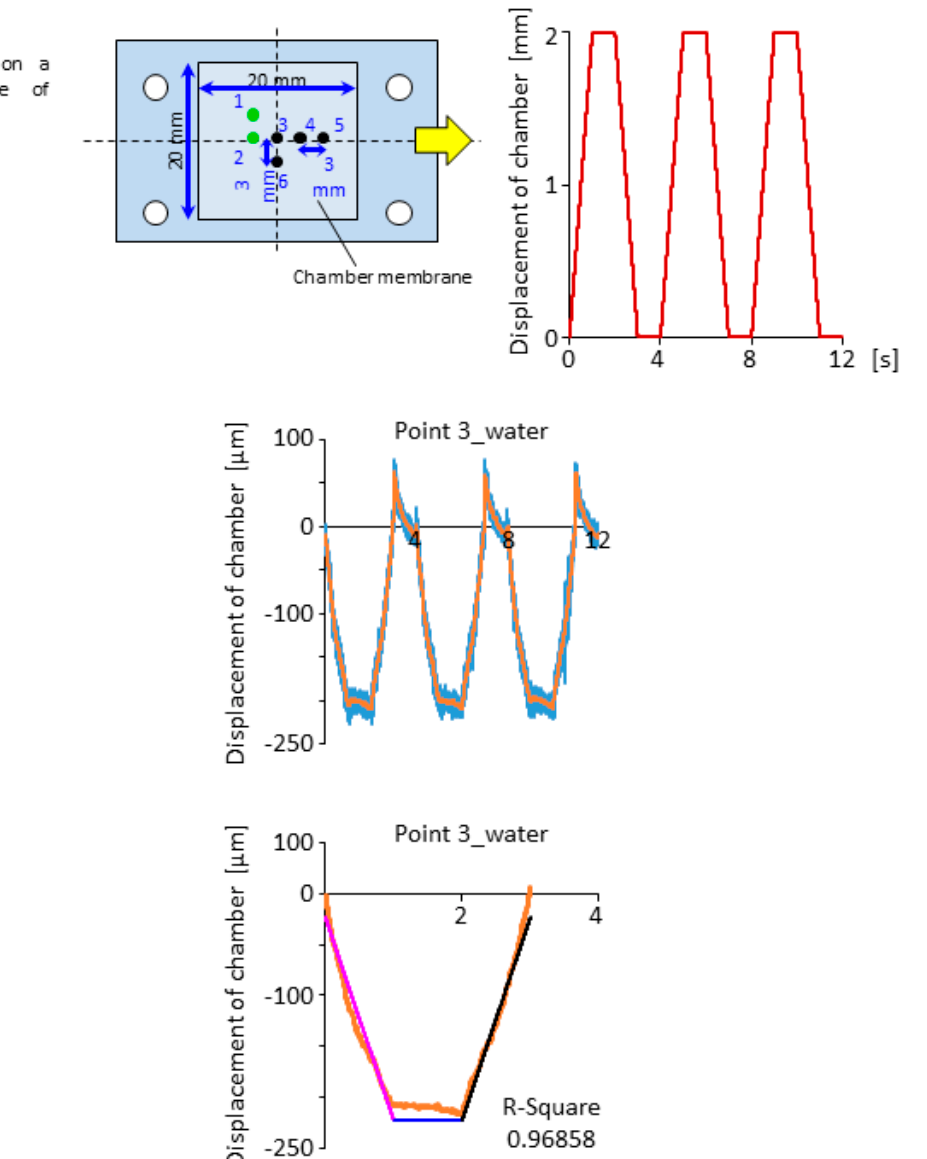
Figure 7. The vertical displacement trajectory of point 3. 1 mL water was added to the stretch chamber before measuring. Lower: the fit results of the stretching / holding / relaxation phases. Original data is in light blue and filtered data in orange. The lines with color in purple, blue, and black are the lines fitting for the lengthening, holding, and relaxation phases, respectively.